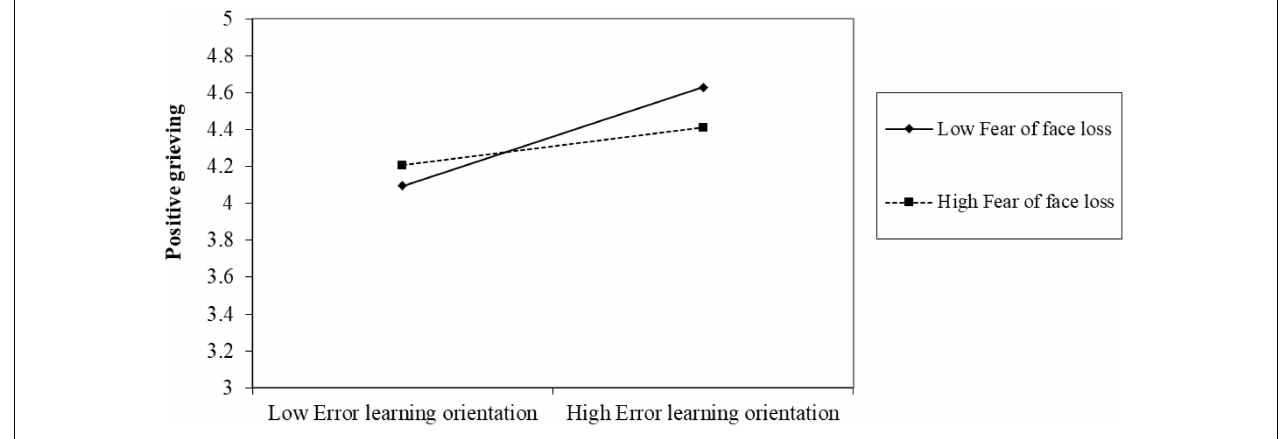
FIGURE 2 | The moderating role of fear of face loss in the relationship between error learning orientation and positive